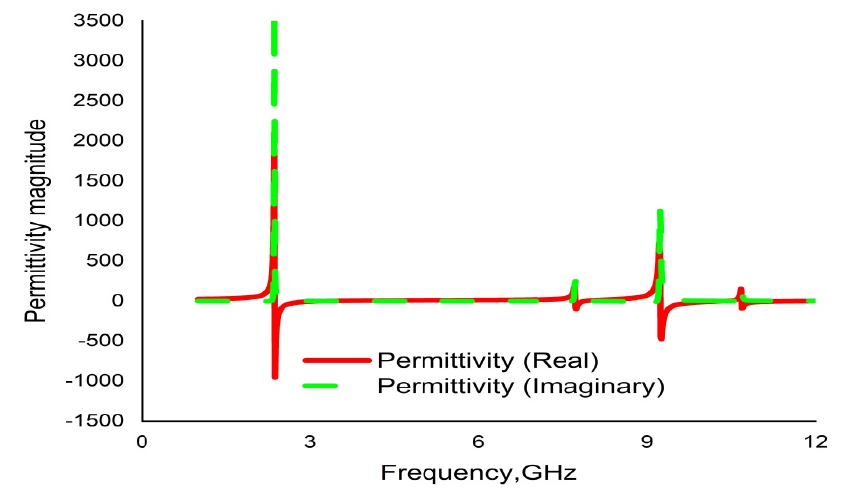
11 and S 21 ) of the unit cell.